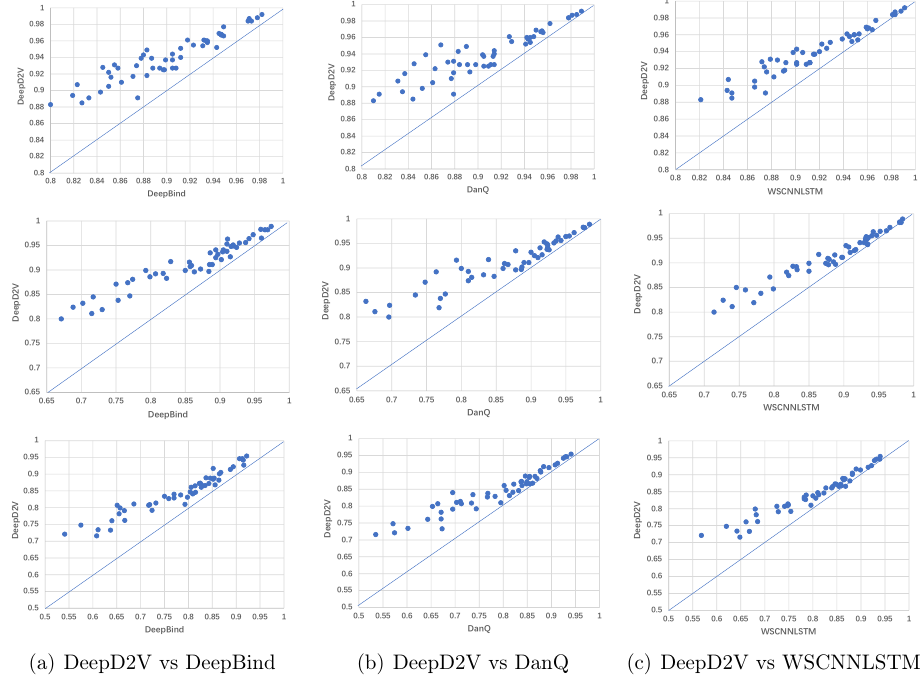
Figure 8. Comparison of DeepD2V and the competing methods on in vivo data. ( a ) Comparison of Figure 1: Comparison of DeepD2V and the competing methods on in-vivo data, where the first row cor- DeepD2V with DeepBind under the ROC AUC, PR AUC and F1 metrics. ( b ) Comparison of DeepD2V responds to a comparison of DeepD2V with DeepBind, DanQ and WSCNNLSTM under the ROC AUC metric, and the second row corresponds to a comparison of DeepD2V with competing method under the PR with DanQ under the ROC AUC, PR AUC and F1 metrics. ( c ) Comparison of WSCNNLSTM with AUC metric, and the third row corresponds to a comparison of DeepD2V with competing method under DeepBind under the ROC AUC, PR AUC and F1 the F1 metric.